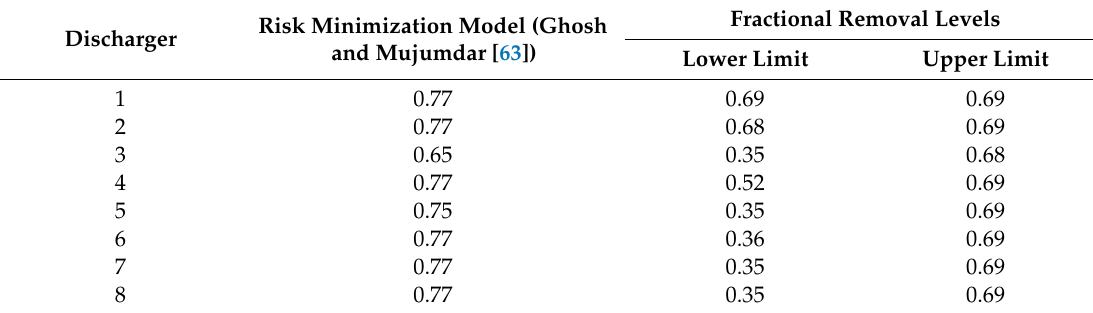
Table 1. Results from the IFWLAM optimization models of upper and lower limit of fractional removal levels for various dischargers along Tunga-Bhadra River,